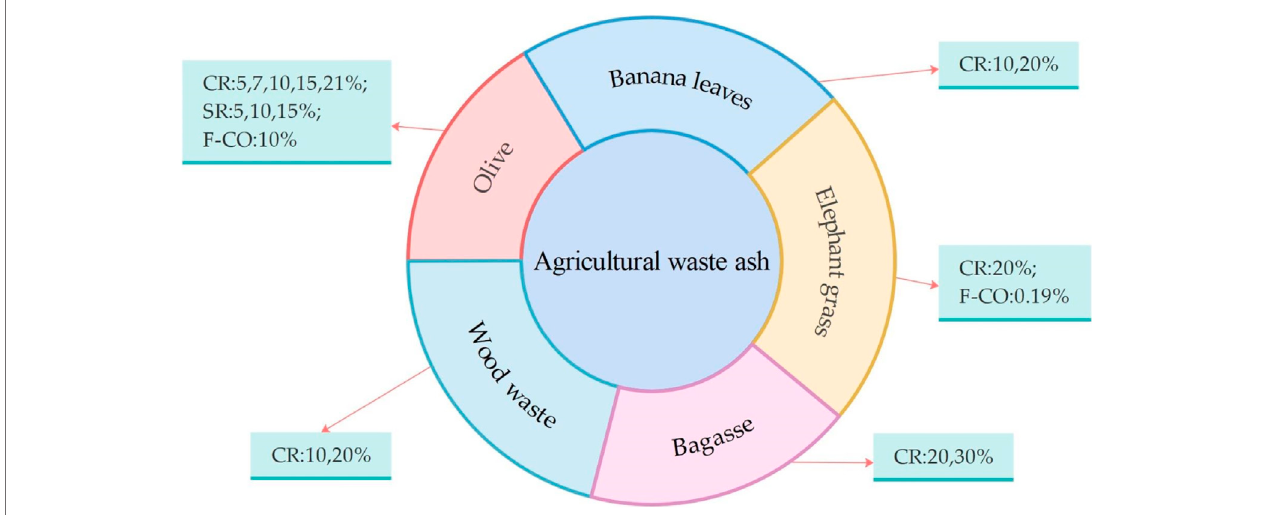
FIGURE 4 | Substitution and mixing amount of agricultural waste ashes in concrete in other